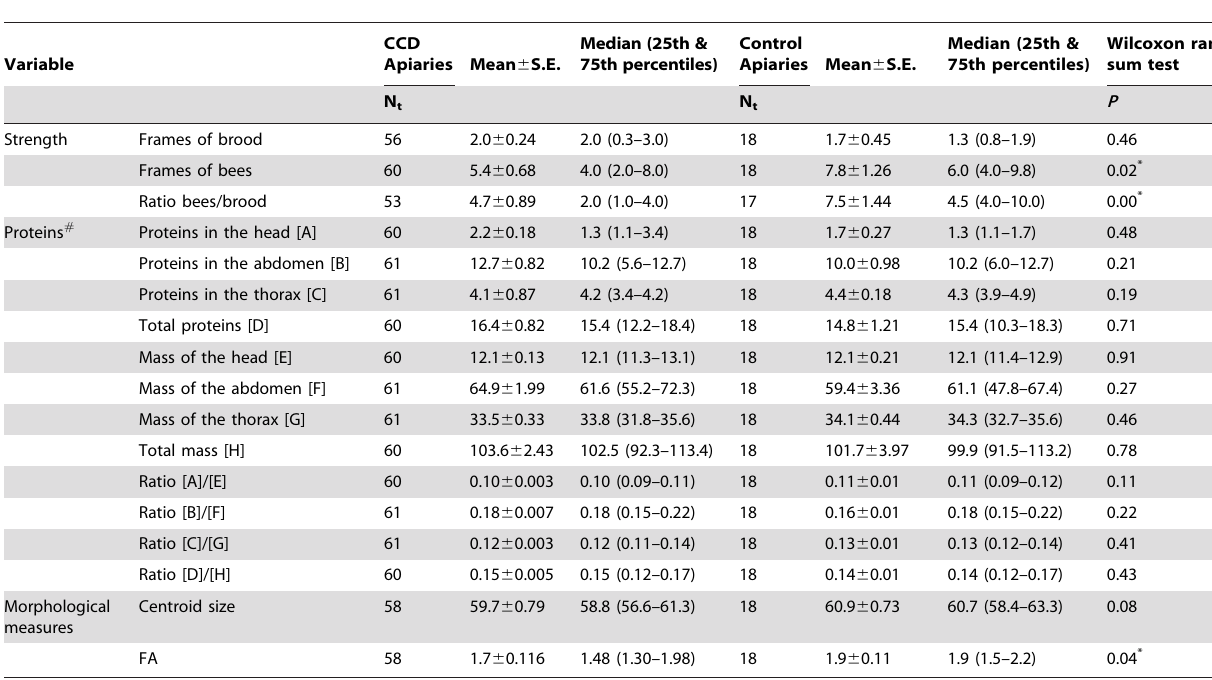
FA: Fluctuating asymmetry. # A total of 6 heads or abdomens or thoraces from one colony were used. * P ,